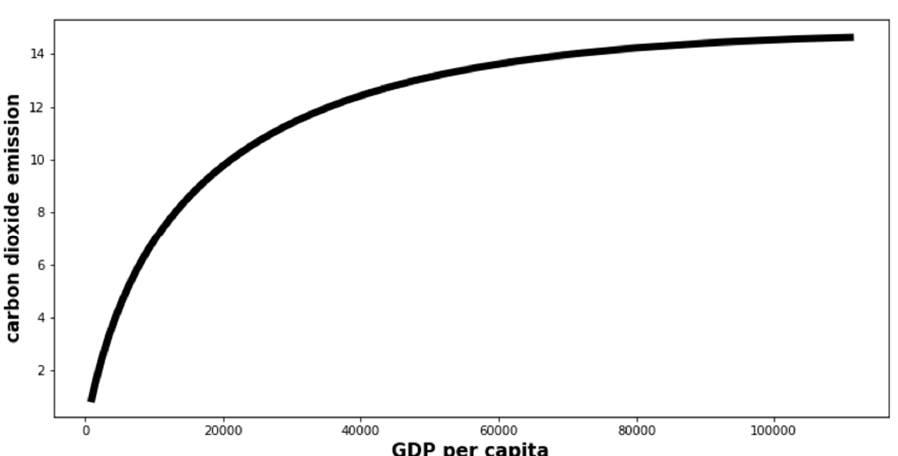
Figure 3. The shape of the Kuznets curve for the considered countries in the period of 2013–2019 (determined based on model (1)).